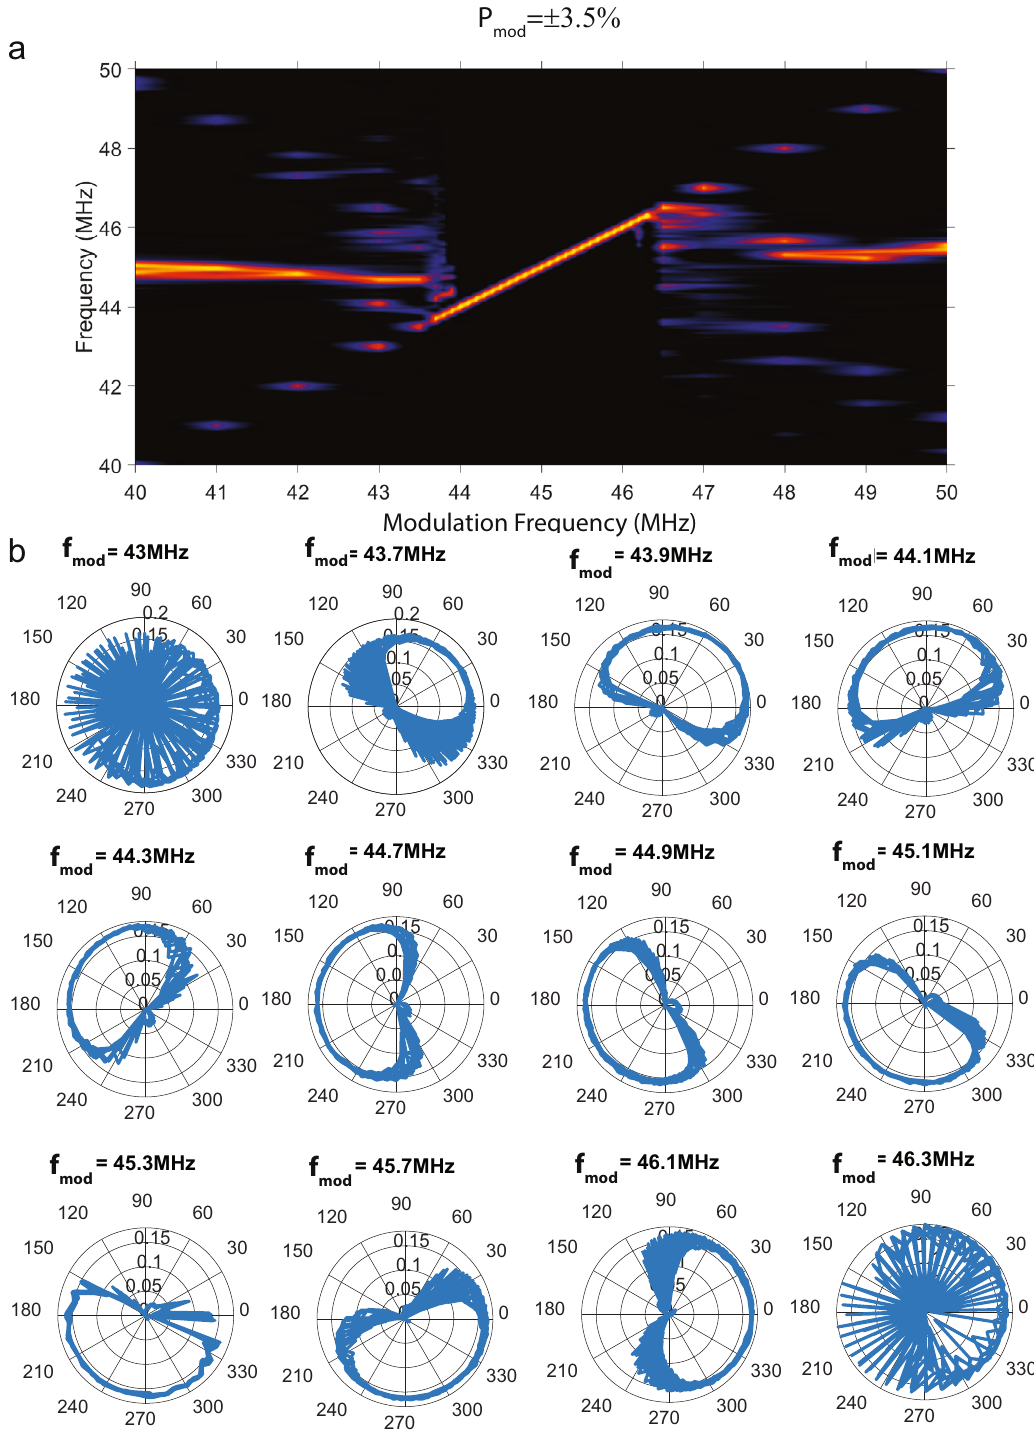
Fig. 6 Arnold tongue for a modulation amplitudes of P mod = ±3.5%. a Colormap of the power spectral density (PSD). b Time traces of the transmission signal in a polar representation, where the distance to the center is the transmission value and the angle is the phase difference with respect to the maximum of the modulation signal. Each panel corresponds to a different modulation frequency, covering the spectral width of the Arnold Experimental measurements of the overall phase shift along the Arnold tongue . We have measured the overall phase shift between the SP limit-cycle and the reference modulation signal along the Arnold tongue for several modulation values. As explained in the main text, these measurements were registered with an oscilloscope by using the reference signal as trigger signal. In the present case, the used oscilloscope owns a bandwidth of 500 MHz instead of 4GHz, which was the case of Fig. 2 of the main text. By comparing Figs. 5a with 6a we can observe the